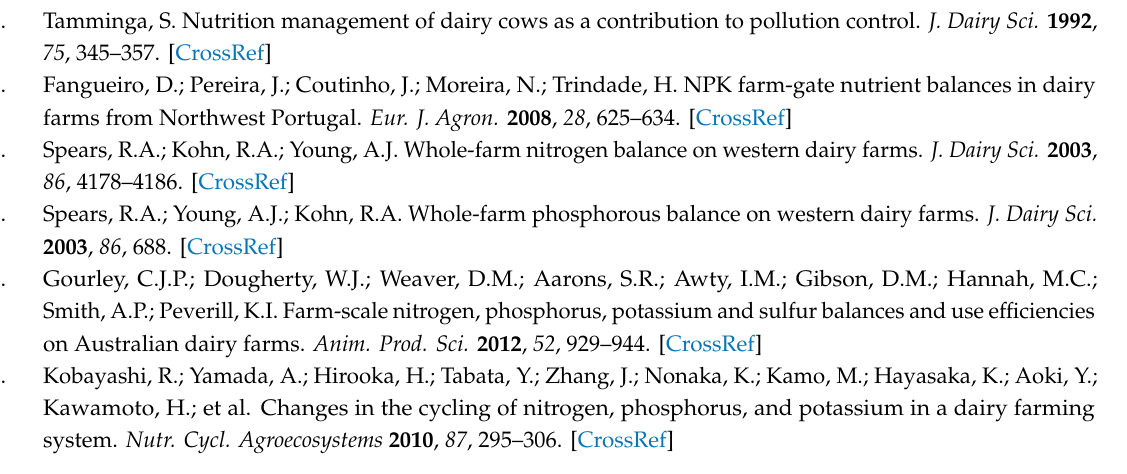
Figure S1: Map showing the location of project farms across temperate, arid, subtropical and tropical zones of Australia. Figure S2: Relationship between calculated pasture dry matter intakes and farmer estimates of what was provided to their lactating herds. Table S1: Herd, milk production, fat and protein concentration and terrain data, as well as calculated milk nutrients, supplement, pasture and total DMI, and nutrient intake, excretion and use e ffi ciency for lactating cows at 5 visits over 4 seasons on 43 commercial dairy farms. Table S2: Amounts and nutrient contents of all feed types consumed by the lactating herds on 5 di ff erent visits to 43 dairy farms; including wastage, estimates by farmer of pasture and where feeder weights were